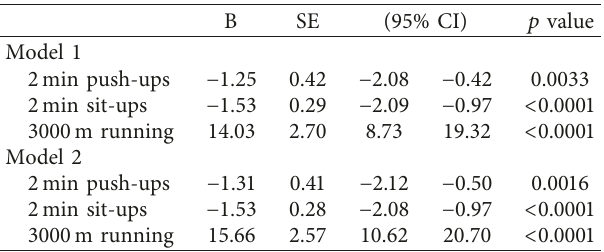
Table 3: Multiple liner regressions of current smoking with each exercise